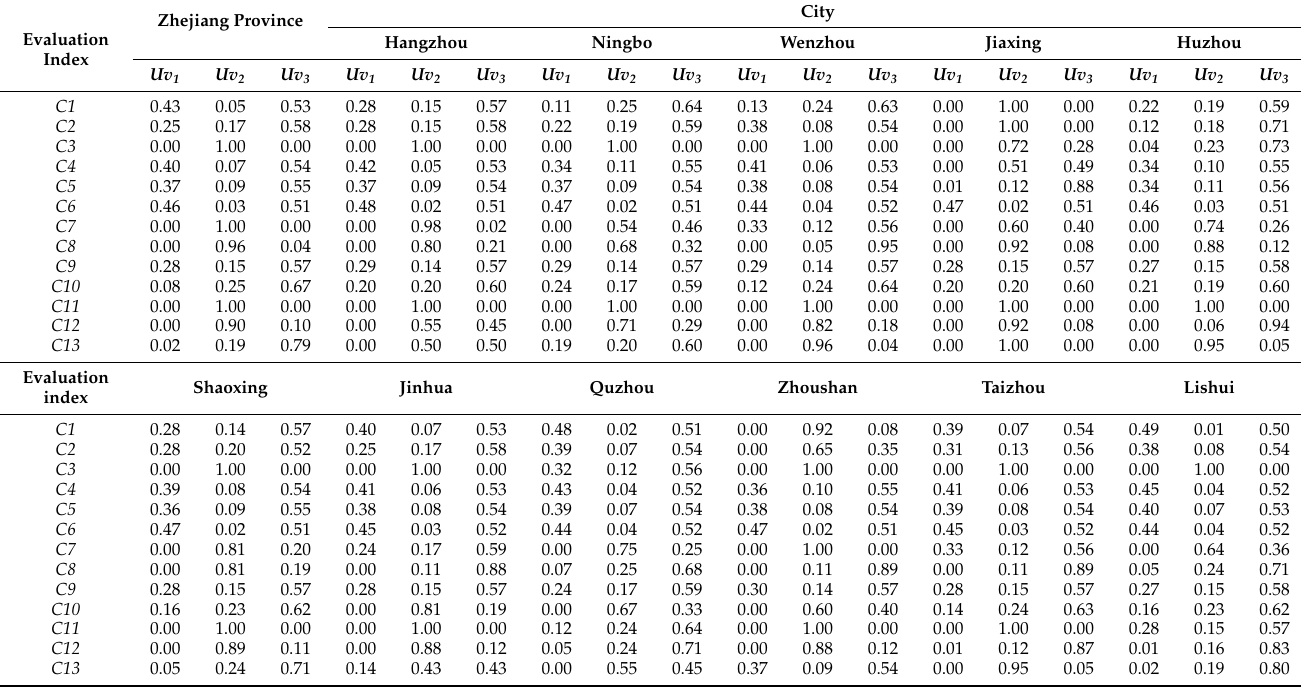
Table A3. The results of various indexes shows the vulnerability of disaster-bearers in Zhejiang